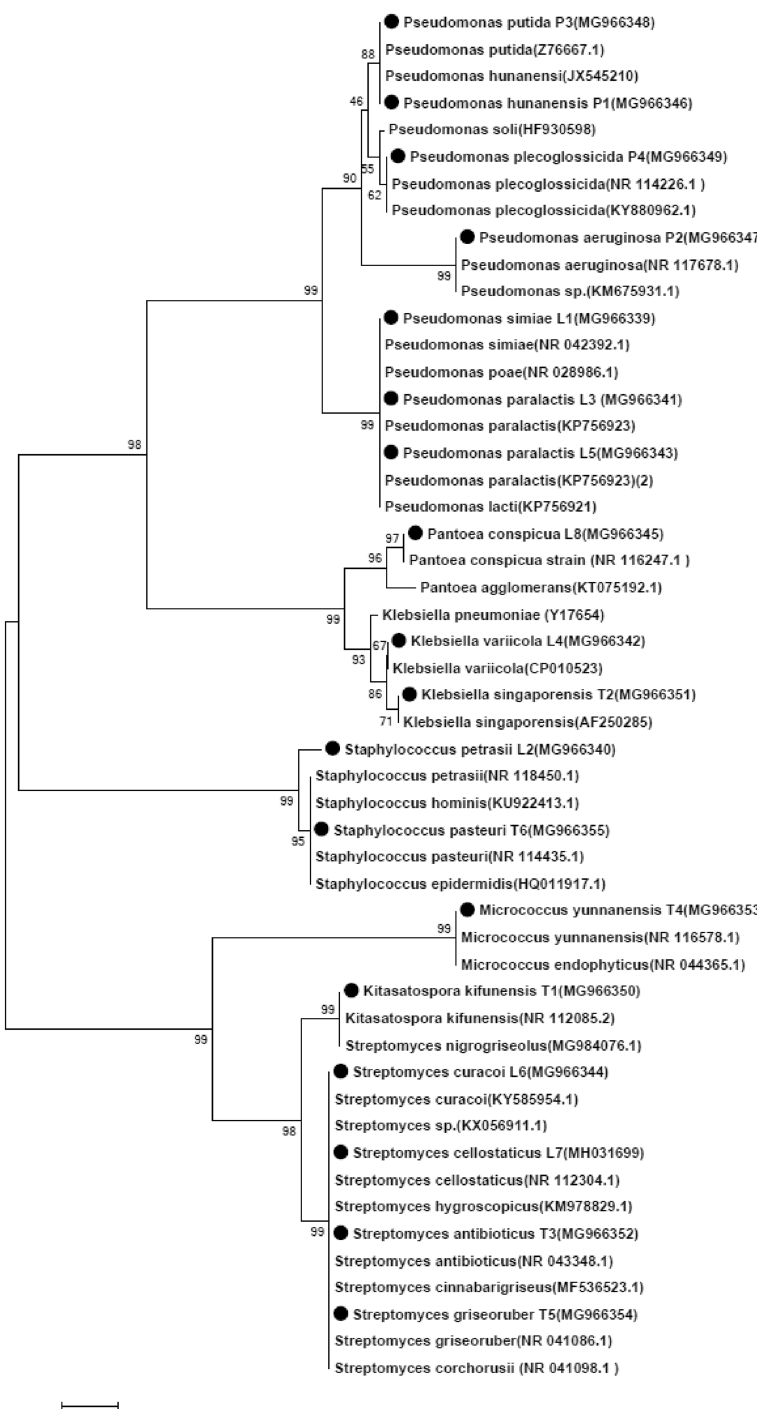
Figure 2. The neighbor joining tree based on 16 SrDNA sequences of bacterial isolates associated with Shisham rhizosphere from three provenances. Tree topology was obtained after 1000 runs. The bootstrap values are indicated at the nodes. Scale bar represents 5 nucleotide substitutions per site. The strains with bold circle are from this